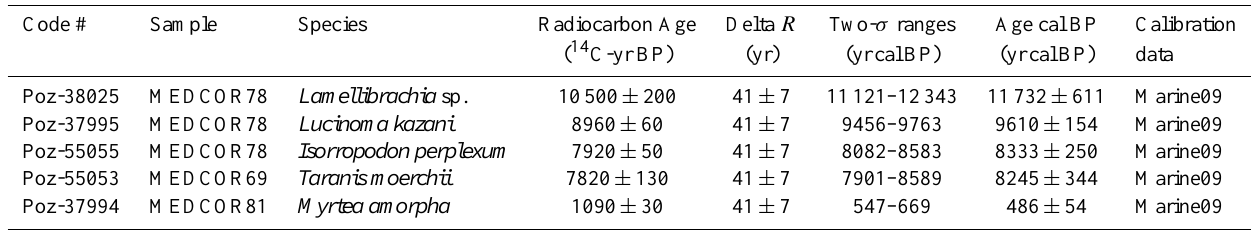
Table 3. Radiocarbon data from the Pozn´an Radiocarbon Laboratory in Pozn´an, Poland. Radiocarbon years ( 14 C-yr) correspond to the true half-life. Calibrated age ranges reflect the 95.4% probability window (2 σ -error) and were calculated with Calib6.0.1, using the surface marine calibration curve MARINE09 by Reimer et al.